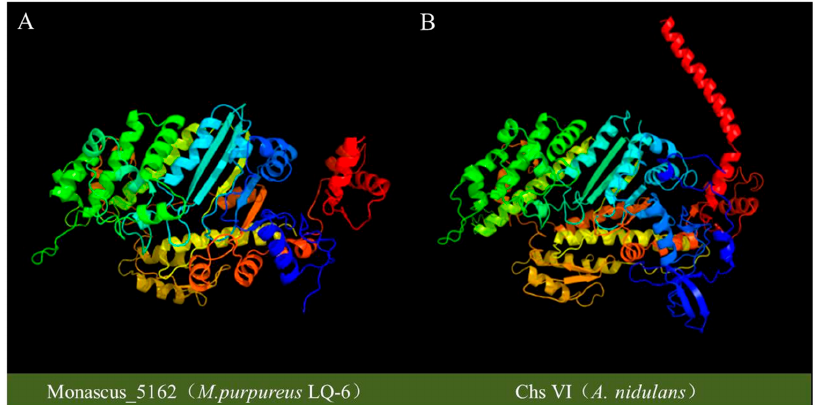
Figure 1. The predicted tertiary structure of protein monascus _5162 from M. purpureus LQ-6 ( A ) and chs 6 from A. nidulans ( B ).